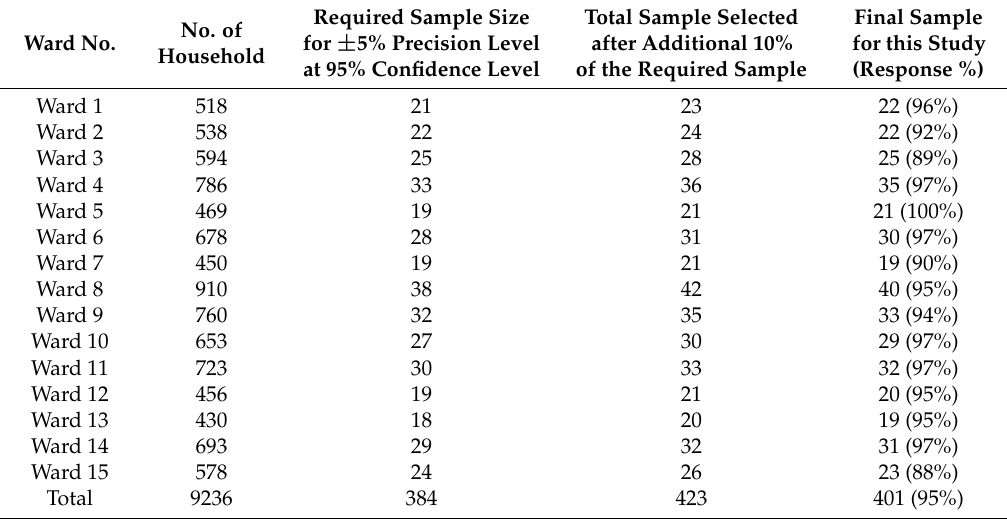
Table 1. Sample selection in Gorkha